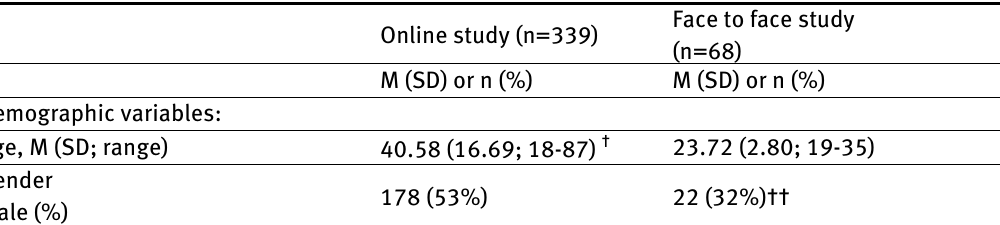
Table 1: Age and gender distribution.